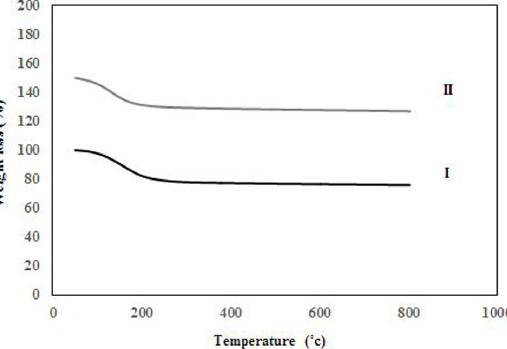
Figure 6: Thermogravimetric analysis (TGA) curve of (I) microporous NaY and (II) hierarchical